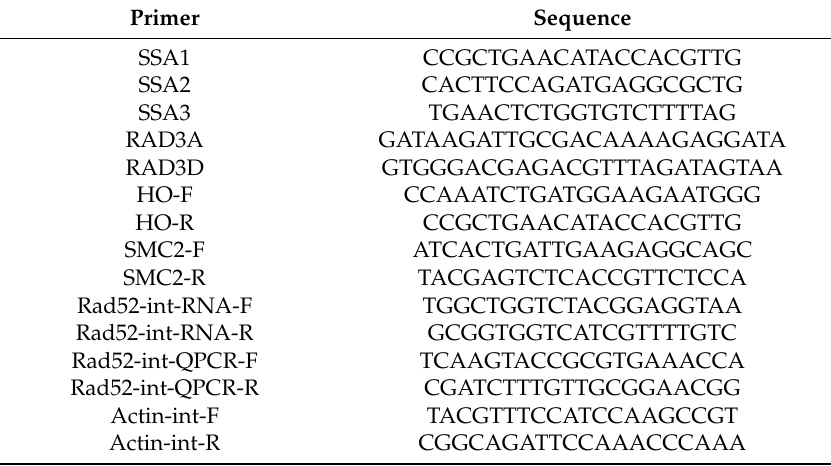
Table 2. Primers used in this